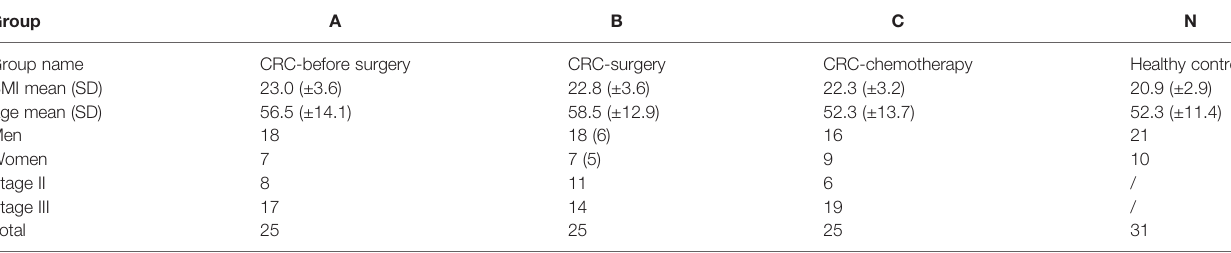
TABLE 1 | Characteristics of subjects in each clinical group.